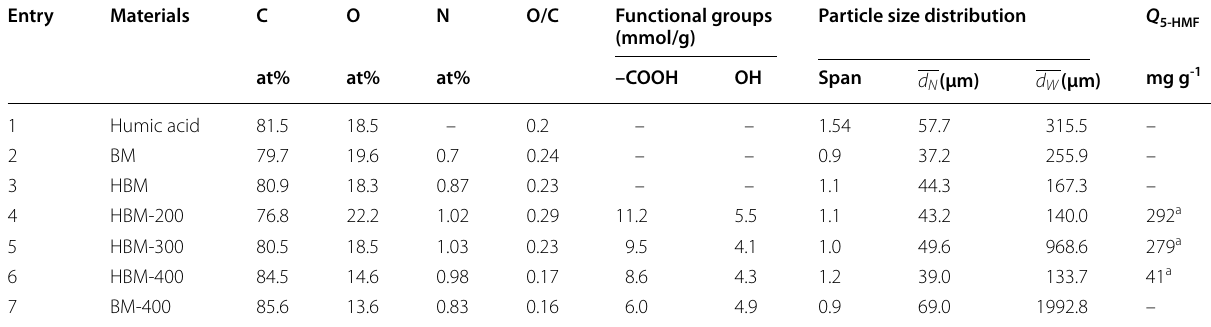
Table 1 Properties, characterization of reference materials and prepared biochars along with biochar adsorption capacities ( Q ) for 5-hydroxymethylfurfural (5-HMF)